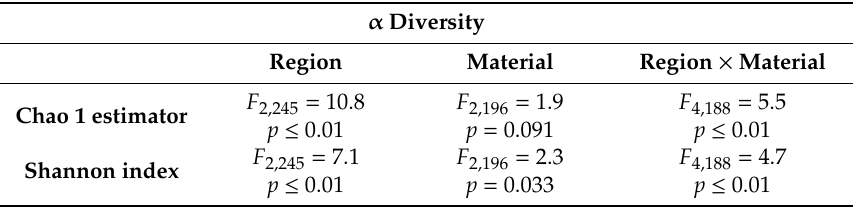
Table 2. Analysis of variance (ANOVA) table for the alpha diversity of Phytophthora species detected in the